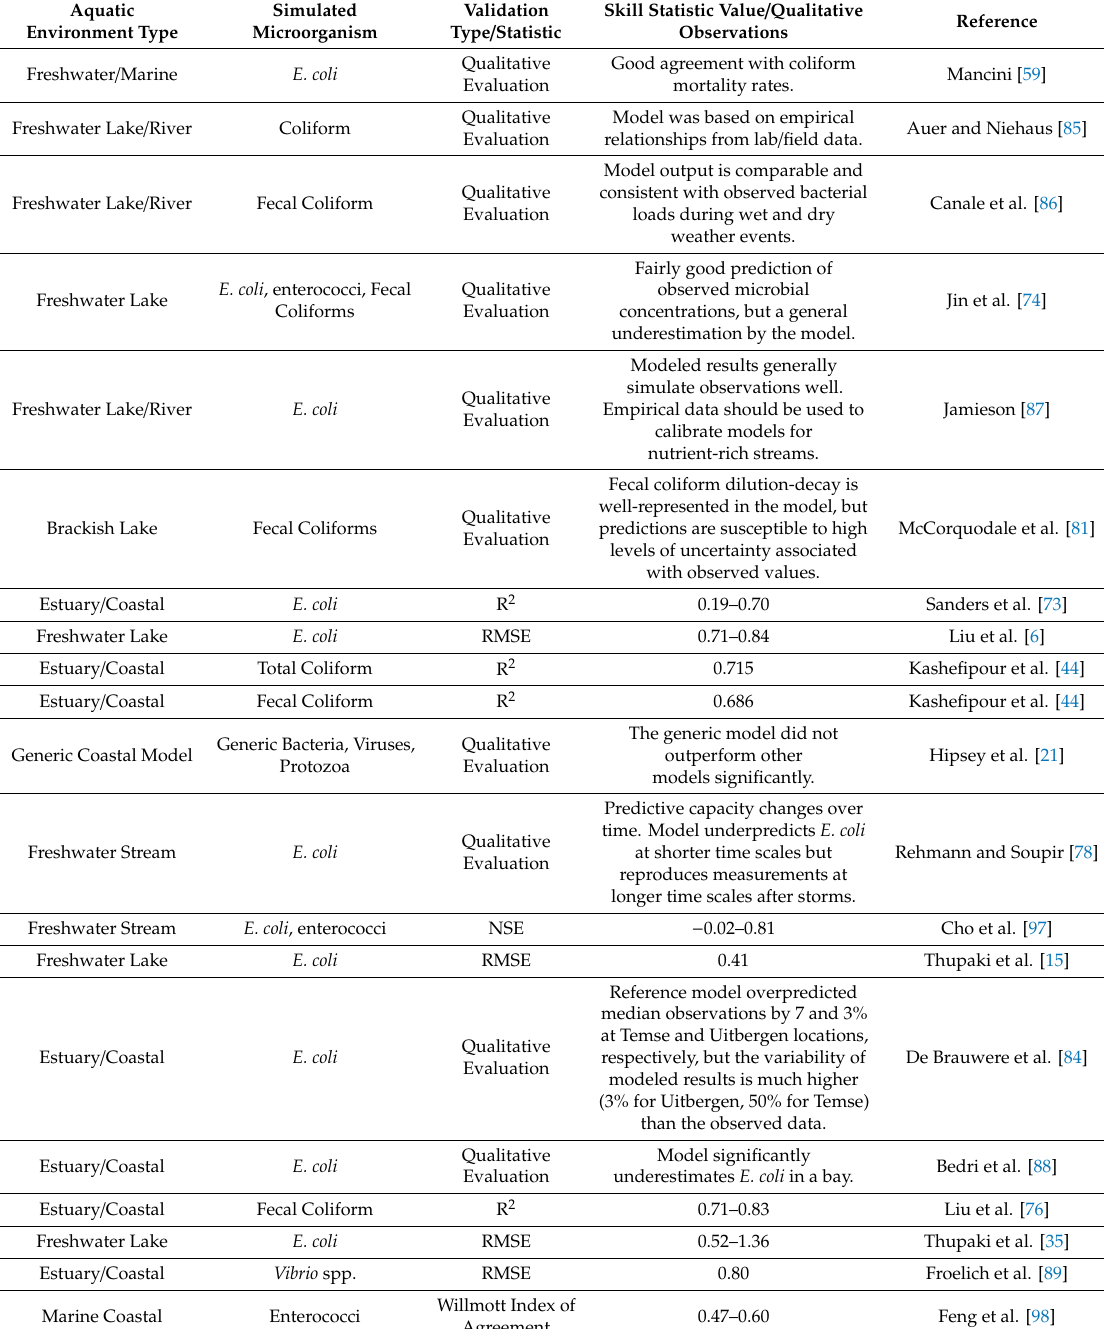
Table 4. Skill statistics and validation data for published numerical models of microbial water quality and FIO fate and